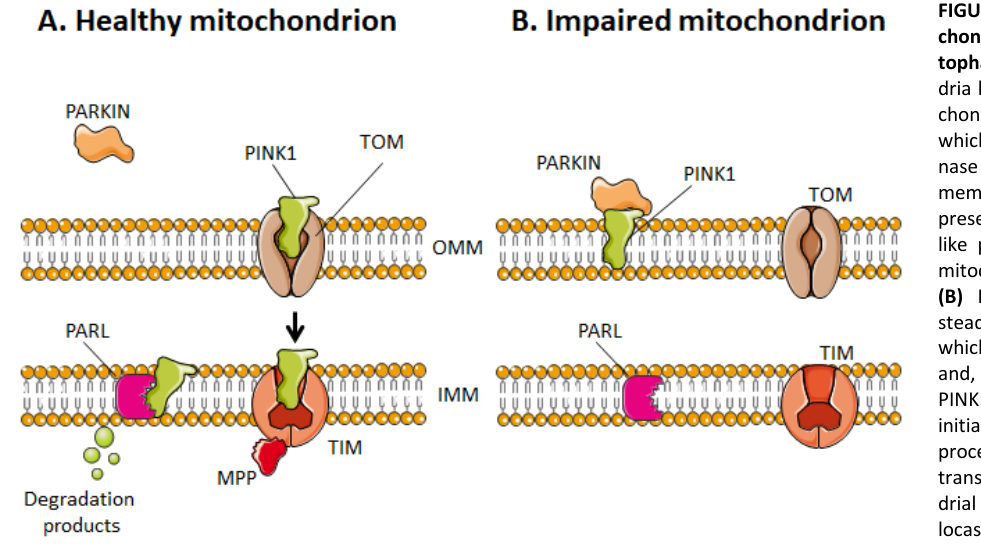
FIGURE 4: Dysfunctional mito- chondria are targeted to mi- tophagy . (A) Healthy mitochon- dria have a polarized outer mito- chondrial membrane (OMM), which allows PTEN-induced ki- nase 1 (PINK1) to cross the membrane and be degraded by presenilin-associated rhomboid- like protein (PARL) at the inner mitochondrial membrane